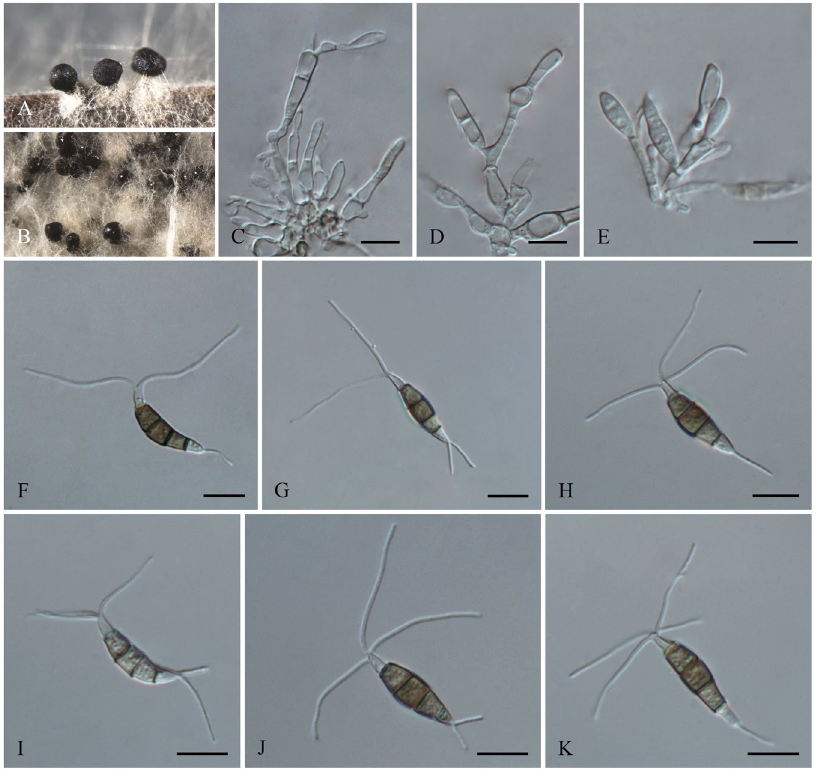
Figure 6. Pestalotiopsis aggestorum (from ex-holotype culture CGMCC 3.18159 ( = LC6301)). ( A ) Conidiomata sporulating on pine needle. ( B ) Conidiomata sporulating on PDA. ( C – E ) Conidiogenous cells and conidia. ( F – K ) Conidia. Scale bars = 10 μ